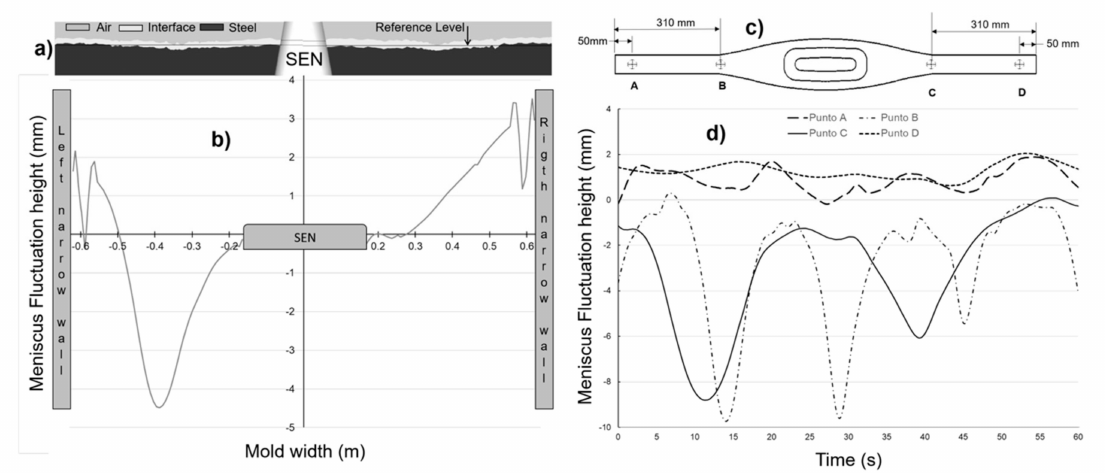
Figure 4. ( a ) Schematic view of the phases and meniscus position, ( b ) meniscus fluctuation during steady-state conditions, ( c ) schematic top view of the mold and ( d ) meniscus fluctuation during unsteady-state